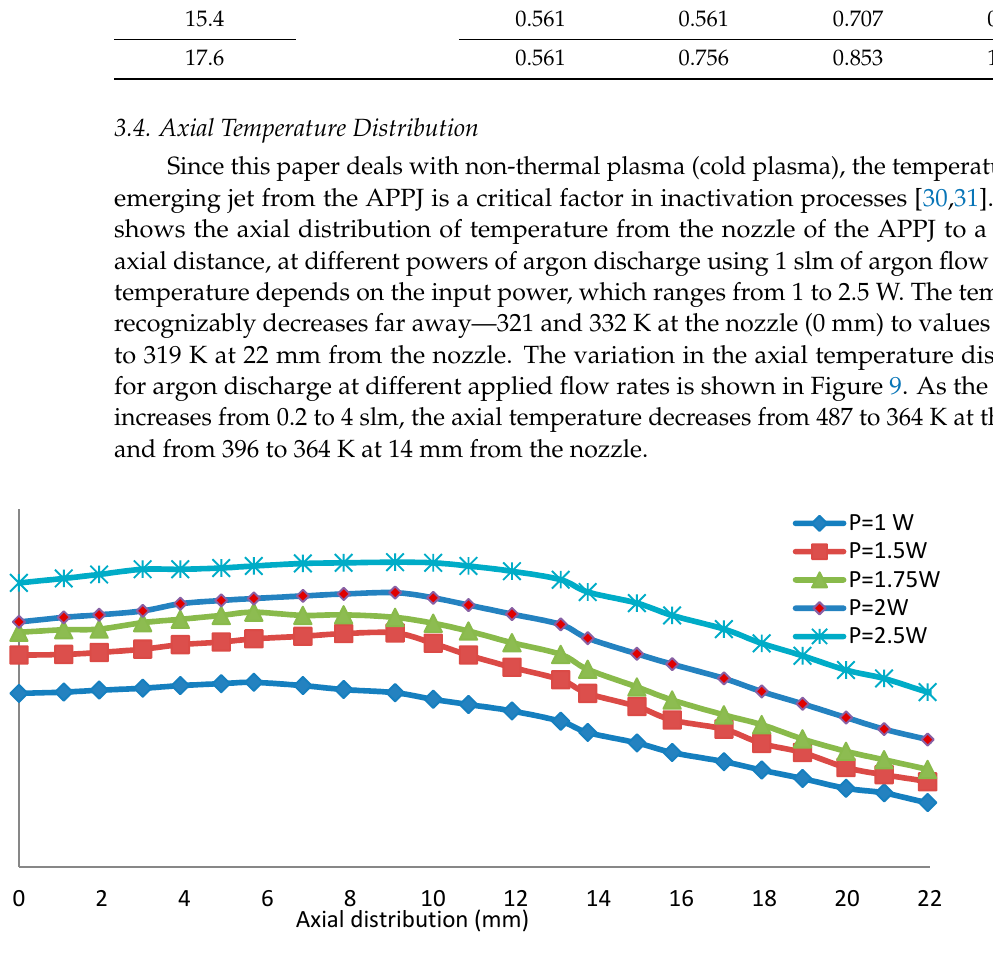
Figure 8. Axial distribution of temperatures from the nozzle of the plasma source at different powers for argon discharge.